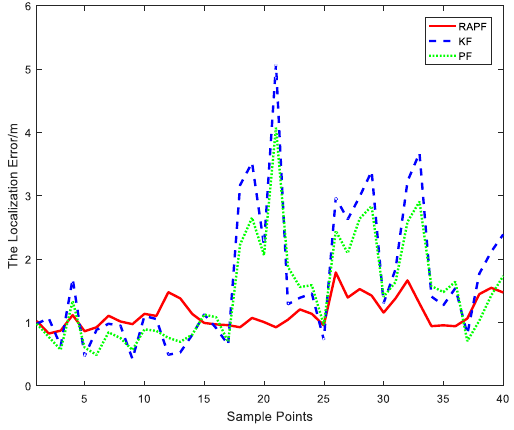
Figure 22. Localization error at each sample points.